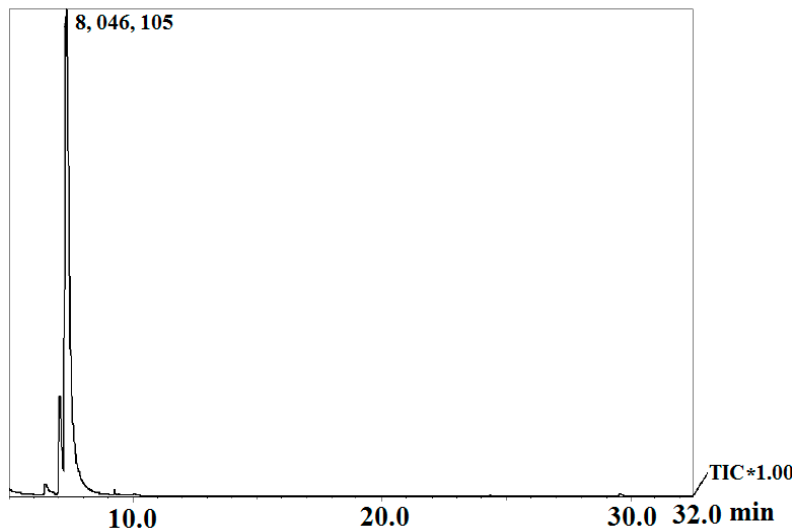
Figure 4. The total ion current for GC-MS analysis on the components of cinnamon oil. Table 2. The relative contents of chemical consistent in cinnamon oil analyzed by